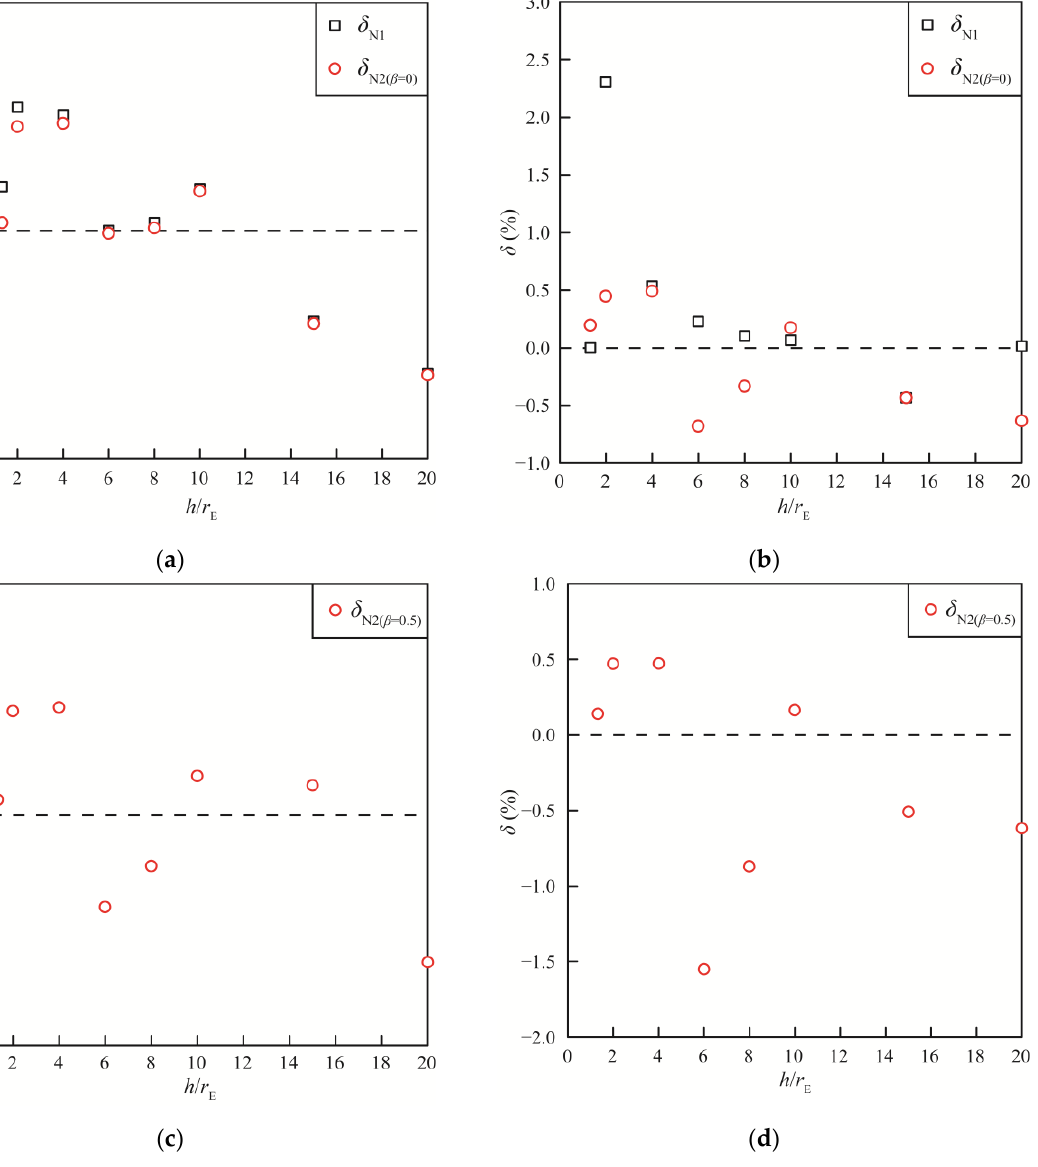
Figure 4. Differences in numerical methods with analytical solutions with various h / r